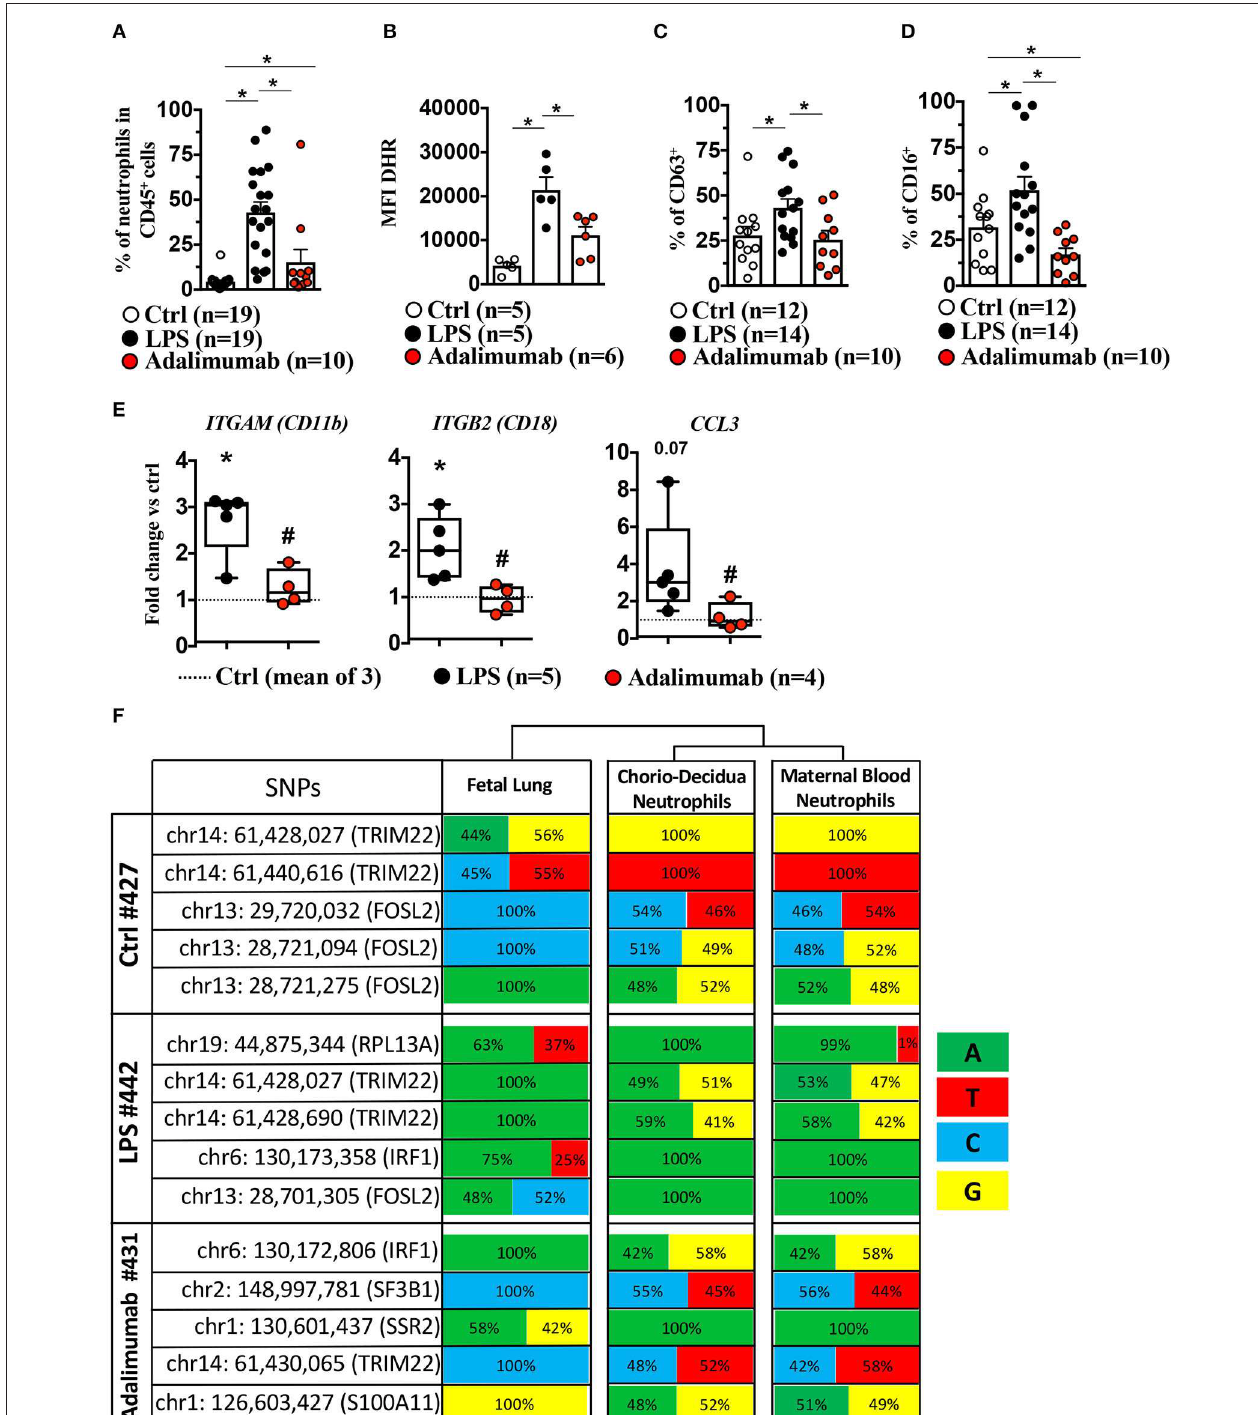
FIGURE 4 | Adalimumab decreased LPS-induced chorio-decidua neutrophil accumulation and activation. Chorio-decidua cells were scraped and digested with protease/DNAase, and single cell suspensions were used for multiparameter flow cytometry. Neutrophils were defined as CD45 + CD3 − CD14 low HLADR-CD88 + CD56 − cells. Inhibition of TNF-signaling by Adalimumab decreased significantly neutrophil frequency (Ctrl n = 19; LPS n = 19; Adalimumab n = 10) (A) , neutrophil reactive oxygen species production measured by Dihydro-rhodamine (DHR) fluorescence (Ctrl n = 5; LPS n = 5; Adalimumab n = 6) (B) , CD63 expression, a marker of degranulation of azurophilic granules (Ctrl n = 12; LPS n = 14; Adalimumab n = 10) (C) , and expression of FC γ III receptor CD16 (Ctrl n = 12; LPS n = 14;